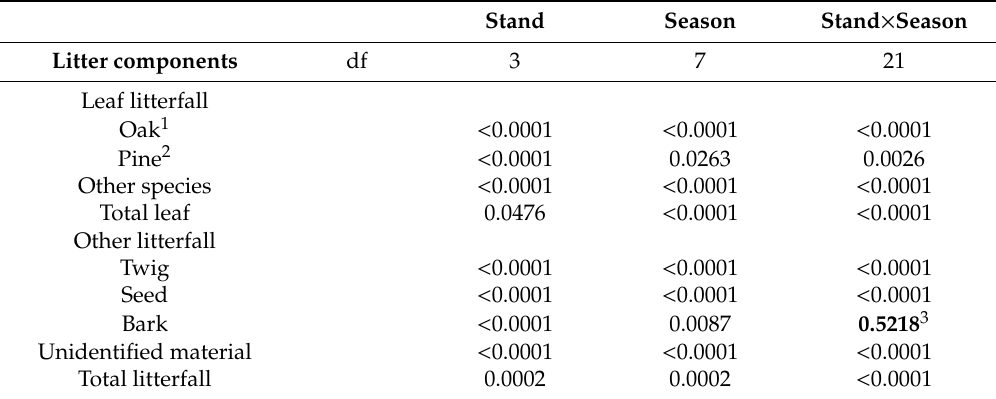
1 Oak denotes leaf litter of Q. glauca and Q. salicina in Cheongsu and Seonheul, and Q. acutissima in Chungnam National University; 2 Pine denotes needle litter of Pinus thunbergii ; 3 P value in bold indicates statistically nonsignificant ( <